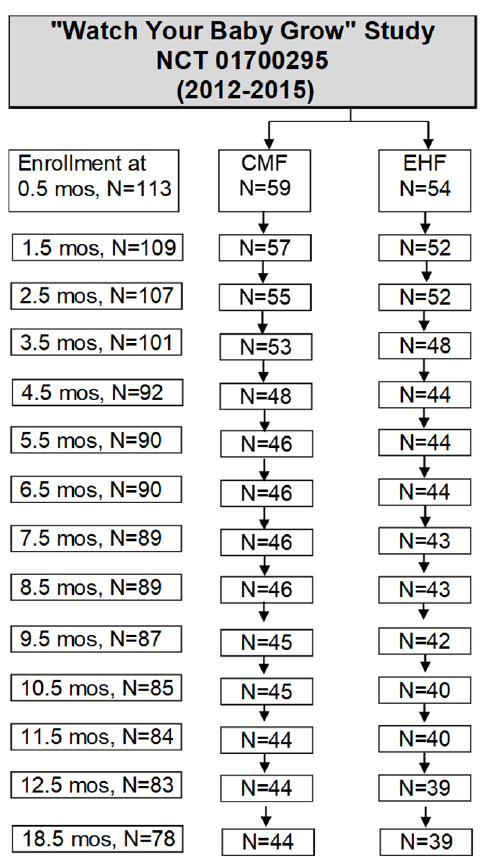
Figure A1. Trial profile of parent randomized controlled trial, NCT01700295. Number of dyads in two randomized groups that differed by type of formula fed (CMF, cow milk formula; EHF; extensive protein hydrolysate formula). Number (N) enrolled at each month of trial up to 12.5 months (1 year), and then 18.5-month (1.5 years) follow-up visit.